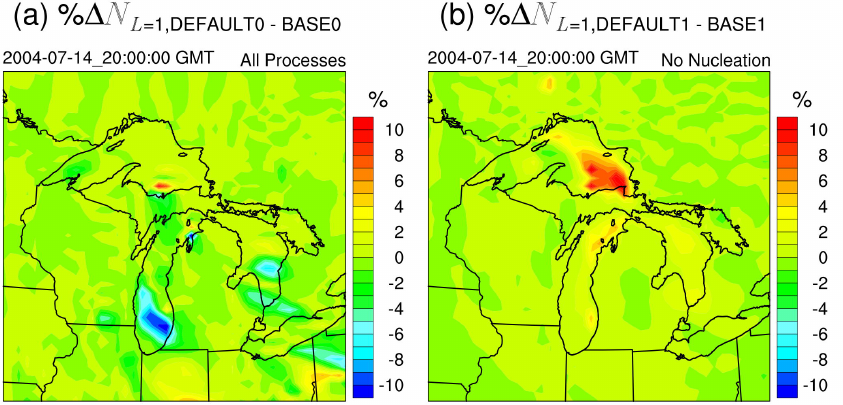
Fig. 9. Percent difference in surface-layer aerosol number concentrations between the DEFAULT and BASE cases for 20:00:00GMT on 14 July 2004: (a) with all aerosol dynamical processes included in the model, and (b) with nucleation turned off in the